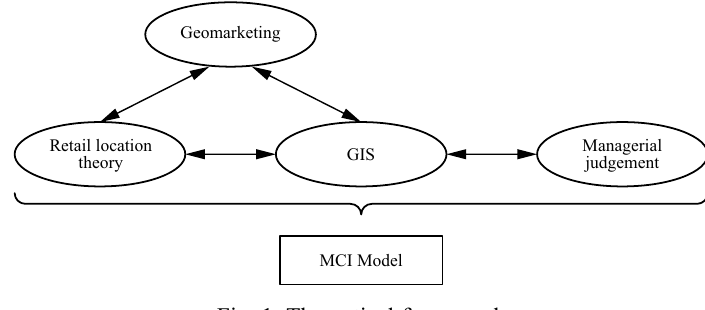
Fig. 1. Theoretical